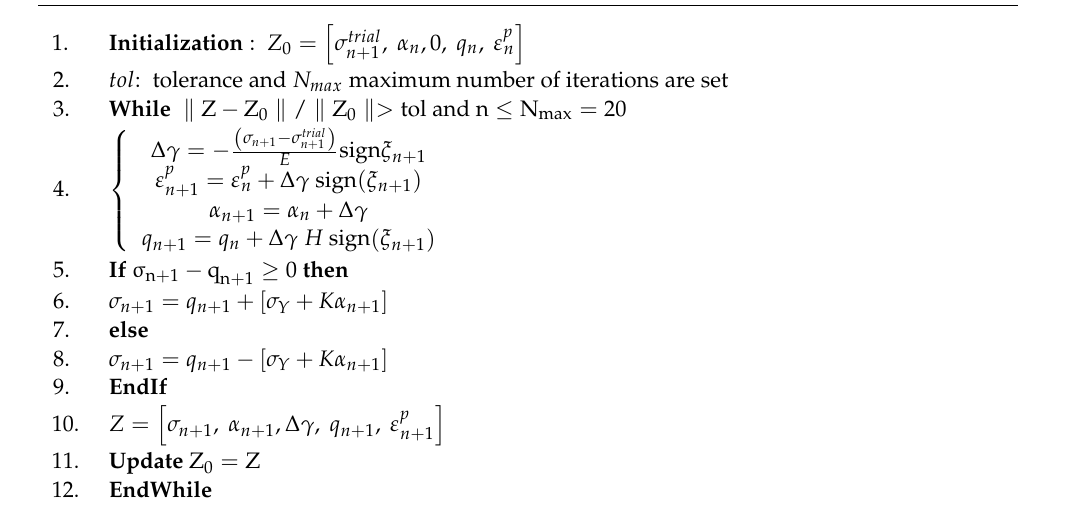
Algorithm 2 : Fixed point method applied to the return mapping